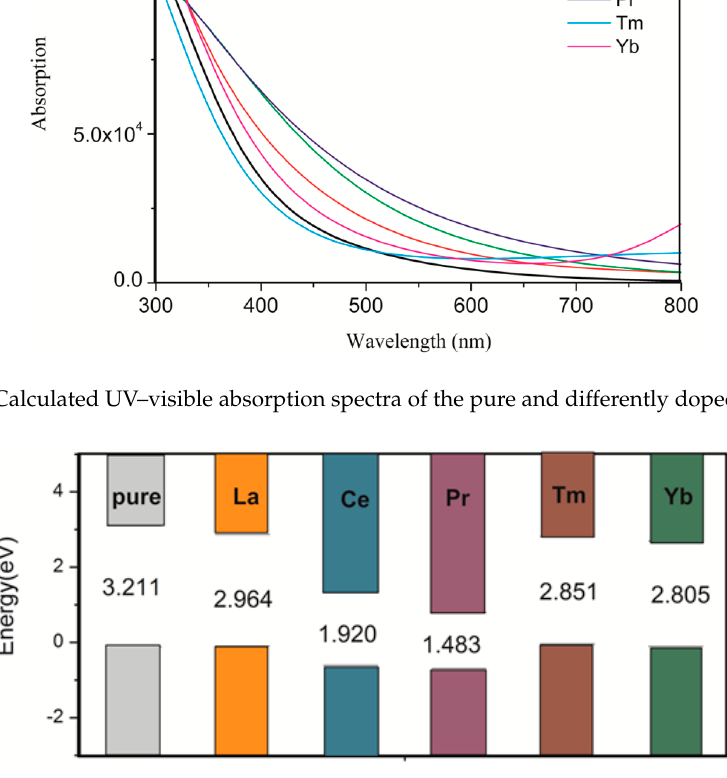
Figure 5. Change in the conduction band minimum and valence band maximum of the anatase TiO 2 doped by single La, Ce, Pr, Tm, and Yb atoms. The Fermi levels are set at the zero of energy.